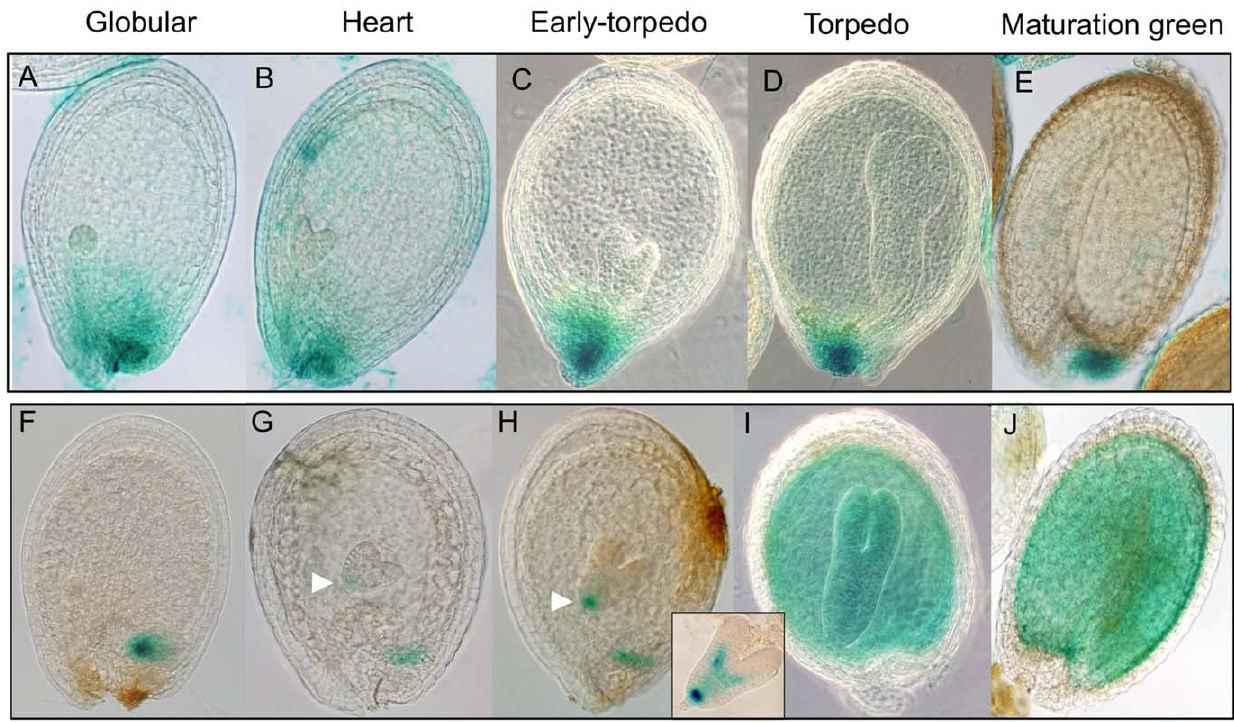
Figure 6. Histochemical analysis of GUS activity during seed development in Arabidopsis lines harbouring transgenes FPS1S::GUS (panels A to E) and FPS2::GUS (panels F to J). Seeds containing embryos at the globular (A and F), heart (B and G), early-torpedo (C and H), torpedo (D and I) and maturation green (E and J) developmental stages were analyzed for GUS expression as described under Material and Methods. GUS expression in the root meristematic region of the embryo at heart (G) and early-torpedo (H) stages in FPS2::GUS seeds is indicated by arrowheads. The inset between panels (H) and (I) shows expression of FPS2::GUS in the root meristematic region and the pro-vascular tissue of an embryo at the early-torpedo